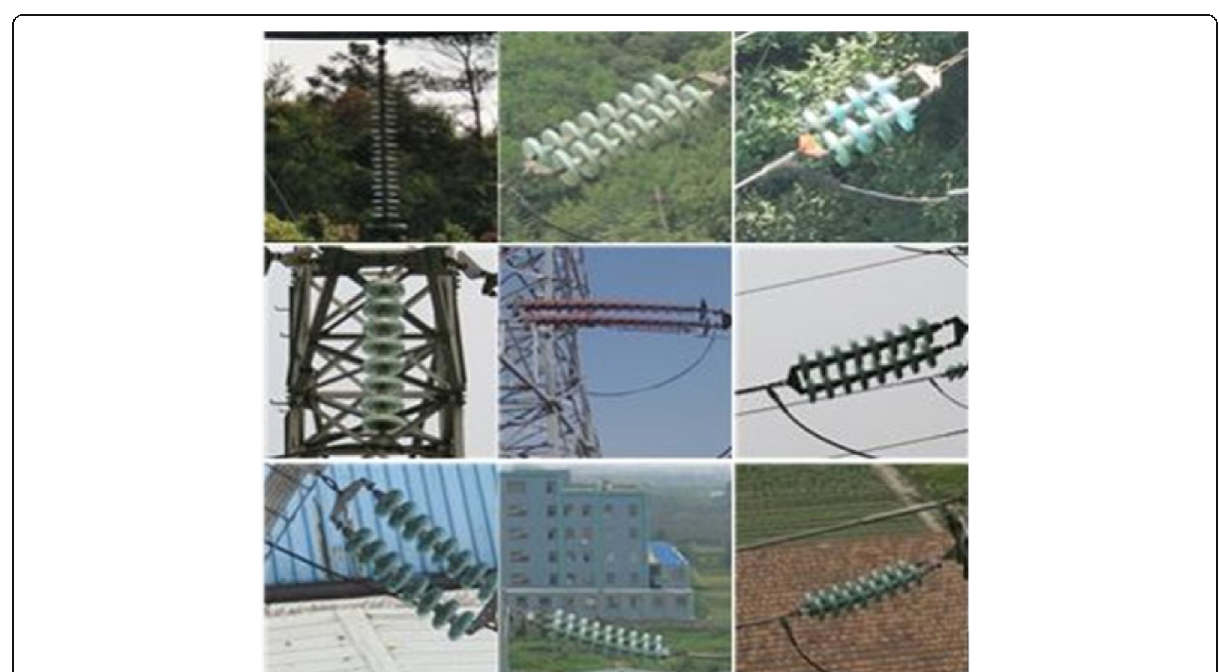
Fig. 1 Example of partial data sample in the real work